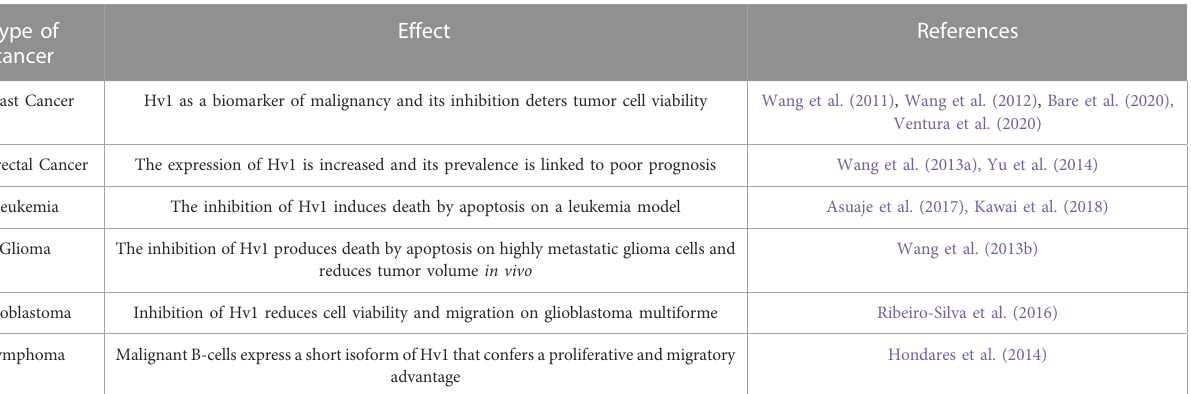
TABLE 2 Presence of the Hv1 channel in tumoral